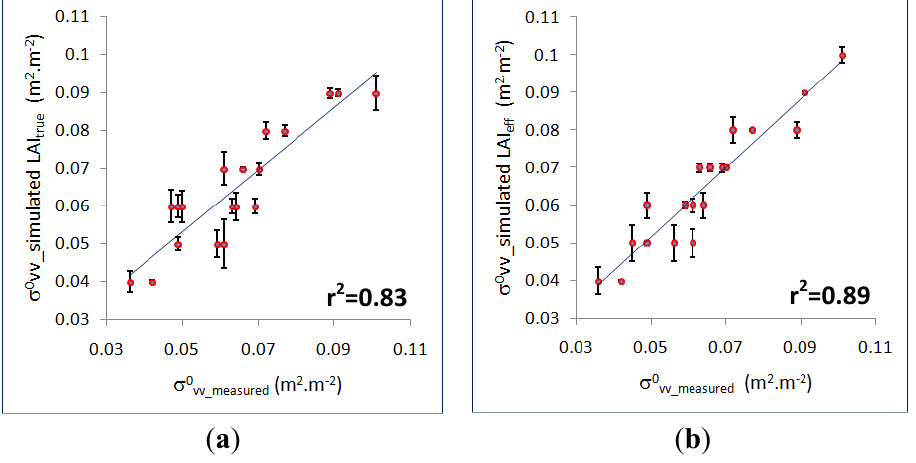
Figure 15. Regression analysis results between measured and simulated 0 the modified Xu and Steven model using, ( a ) True LAI, ( b ) Effective LAI. (Error bars show individual error values).